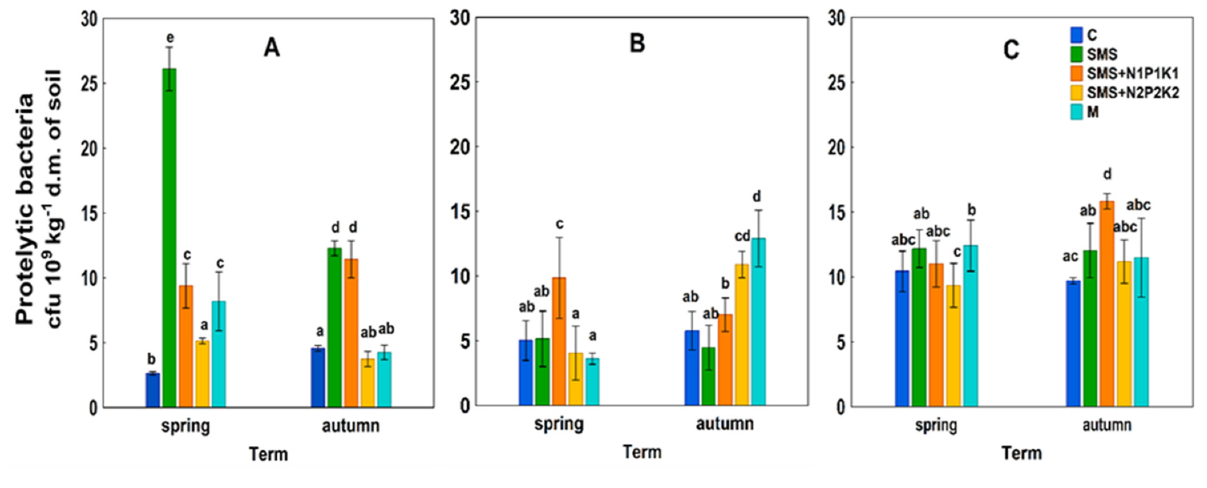
Figure 3. Number of proteolytic bacteria in the soil. Legend: C—control; SMS—soil + spent mushroom substrate; SMS + N1P1K1—soil + spent mushroom substrate + mineral fer- tilization N1P1K1; SMS + N2P2K2—soil + spent mushroom substrate + mineral fertilization N2P2K2; M—soil + manure; ( A )—1st year; ( B )—2nd year; ( C )—3rd year. The vertical lines indicate the standard deviation. Different letters above the columns indicate significant differences, each year was analyzed independently of each other.